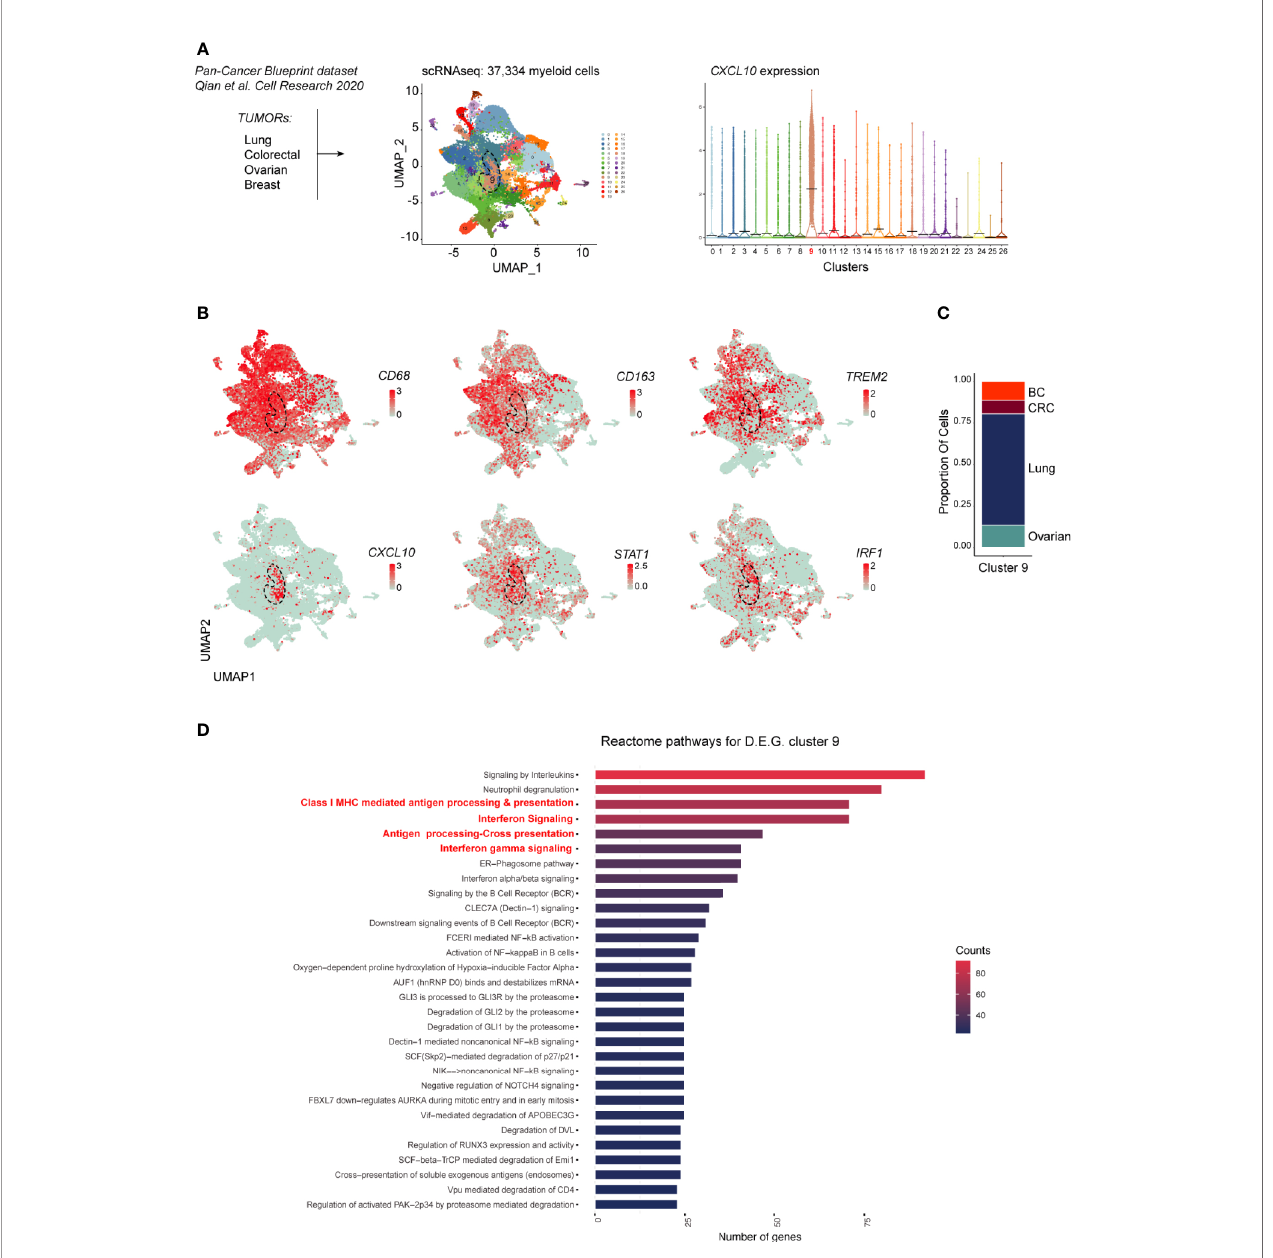
FIGURE 7 | scRNAseq analysis of myeloid cells across cancer types. In (A) is shown the experimental design from published dataset: scRNAseq of myeloid cells (left panel). Dimensionality reduction of scRNAseq data merged from lung, colorectal, ovarian and breast tumors was performed using a Louvain graph-based clustering identifying 27 clusters (middle panel). Each dot represents an individual cell (n = 37,334). Violin plots illustrating expression distributions among the 27 clusters of CXCL10 (right panel). UMAP plot showing expression of CD68, CD163, TREM2, CXCL10, STAT1 and IRF1 (B) . Proportion of cells of the CXCL10+ cluster 9 per tumor type (C) ; BC, breast cancer; CRC, colorectal cancer. Reactome pathway analysis for genes characterizing cluster 9 (adjusted P value <0.05) (D)